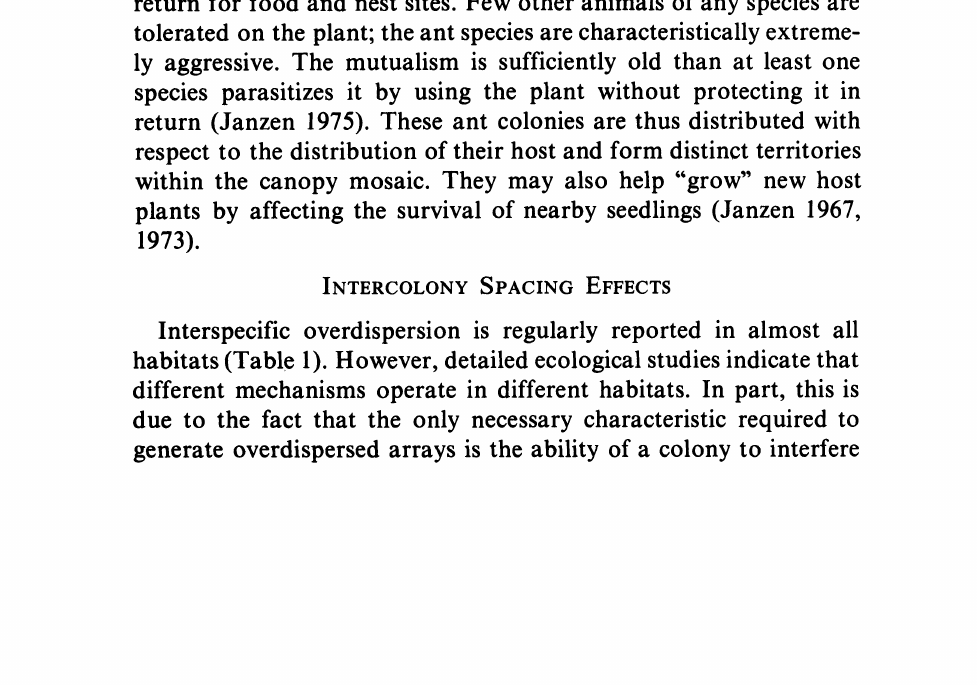
ants (some members of the Pachysima) which protect the return for food and nest